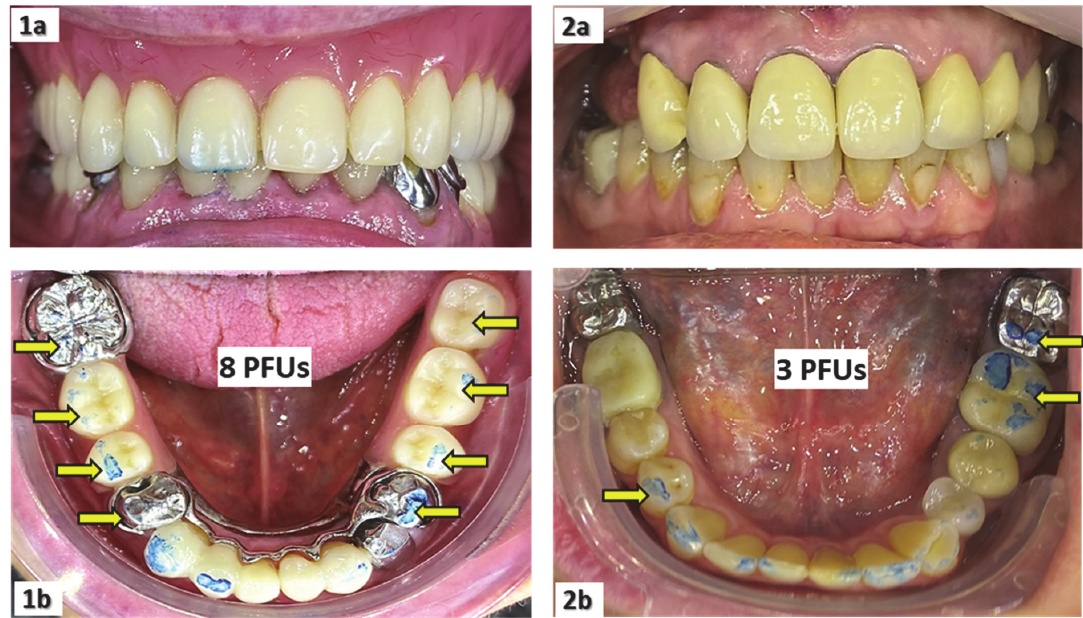
Figure 1. Measurements of the number of posterior functional dental units (PFUs) for a patient using his upper full and lower partial dentures during the previous two meals ( 1a , 1b ), and for another patient who did not use his upper partial denture during the previous two meals ( 2a , 2b ).